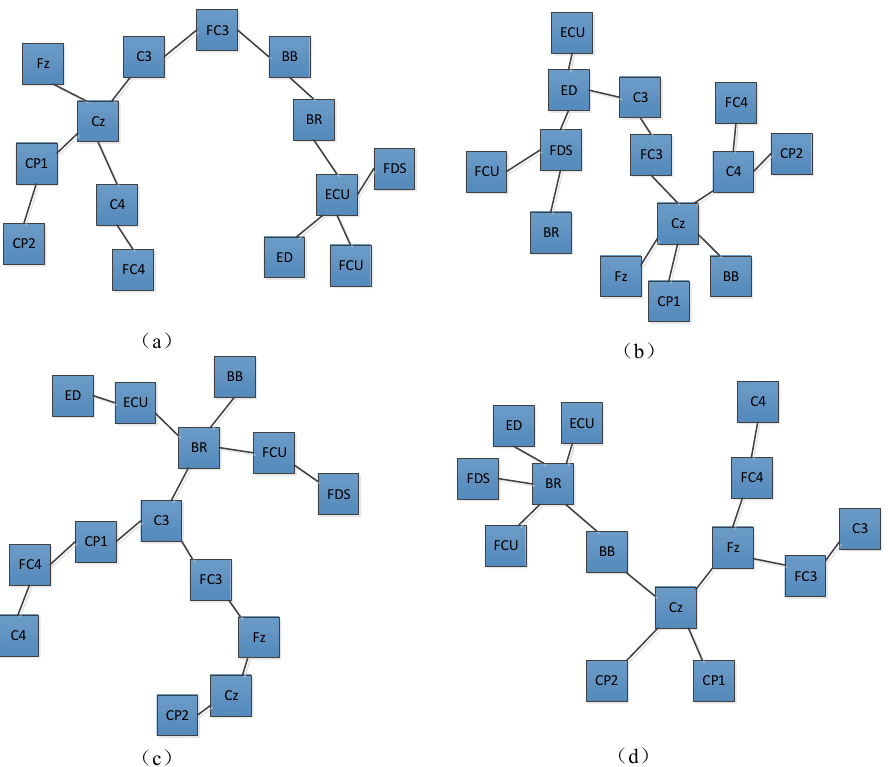
Figure 6. Vine copula first-layer tree structure corresponding to different activities: ( a ) hand open, ( b ) hand closed, ( c ) wrist flexion, ( d ) wrist extension. It can be observed from Figure 4 that the Kendall rank correlation coefficient between EEG and EMG is low for all the four activities. Nevertheless, the EEG signals are highly correlated. We also note that the correlation coefficient between the signals of the same type (EMG–EMG and EEG–EEG) is always higher than that between two different types of signals (EEG–EMG). Generally, the correlation between the Fz and other signals is strong, and the same is true for FC3 and FC4. For the HO and HC movements, a similarly strong correlation exists between the EEG signals. For WF and WE, the correlation between the EEG signals is similar. Meanwhile, the Kendall rank correlation of the FDS and FCU is higher than that of the other EMG channels for WF. However, in the case of WE, the correlation between BR and ECU is higher compared with that for other EMG